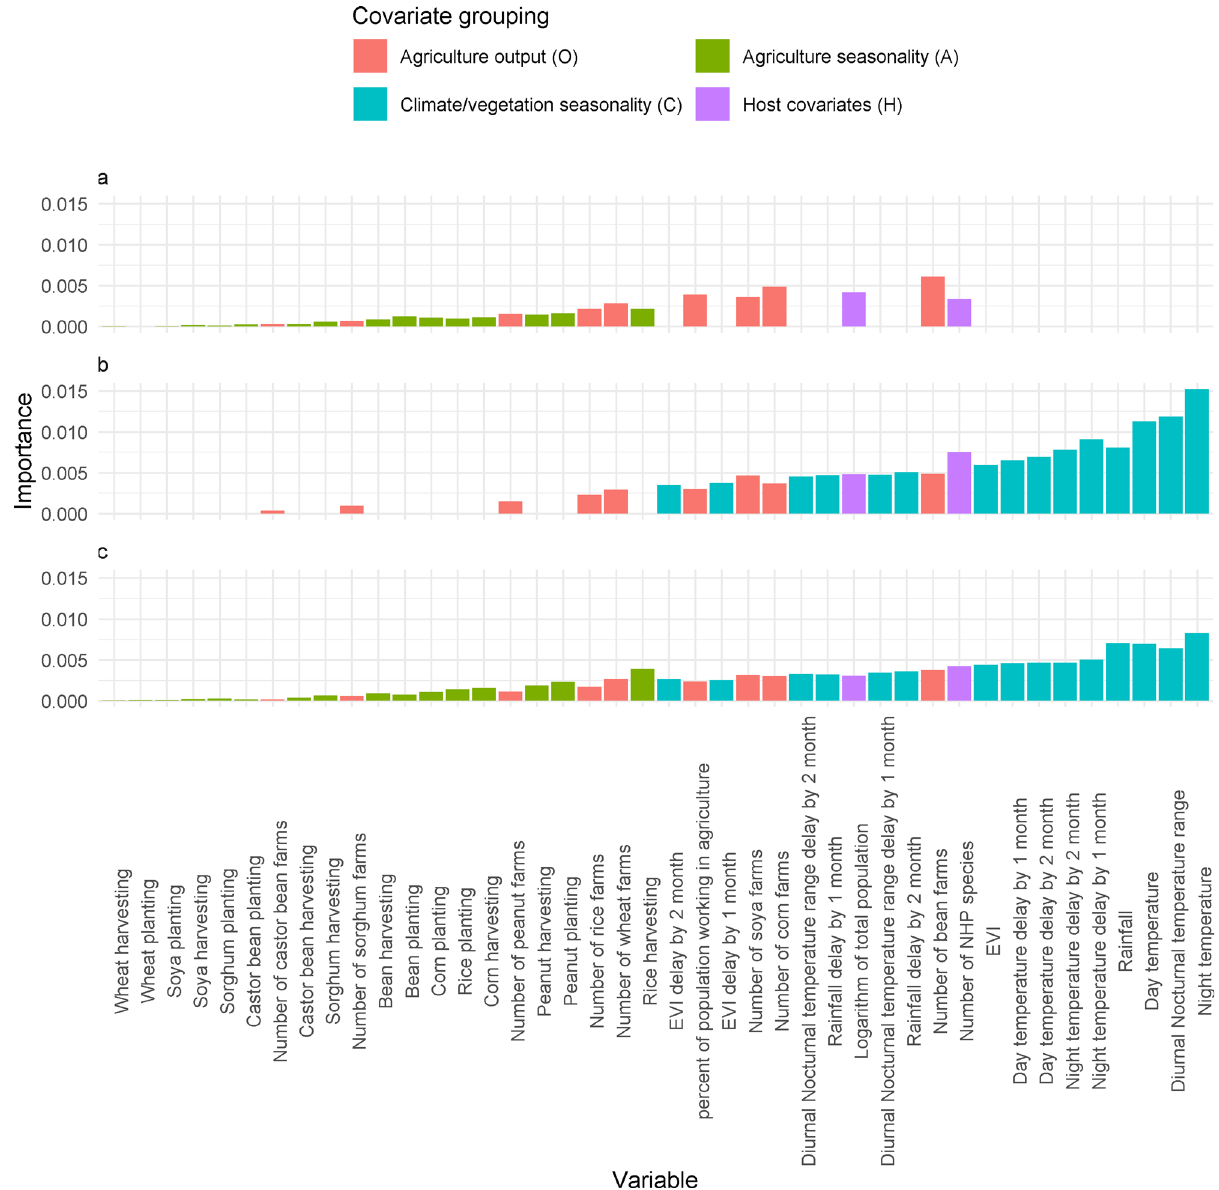
Fig. 5 Covariate variable importance for models looking at the seasonality of climate, agriculture and both. Variable importance values for A the model with agricultural seasonality but not climate seasonality, model OHA, B the model with vegetation/climate seasonality but not agricultural seasonality, OHC and C the model with both agriculture and vegetation/climate seasonality, model OHAC. Variables are omitted when note present in the